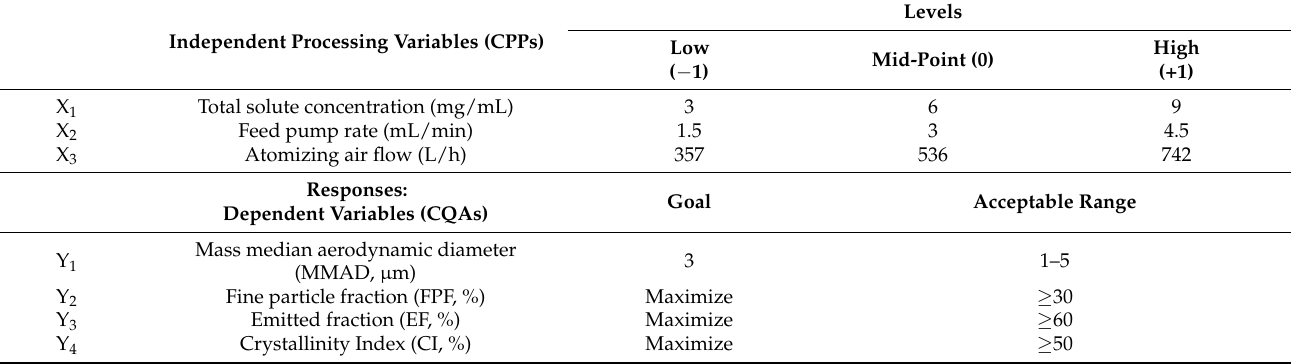
Table 1. Design of the two-level three-factor full factorial DOE to study the spray dried FAV-THP cocrystal powder.